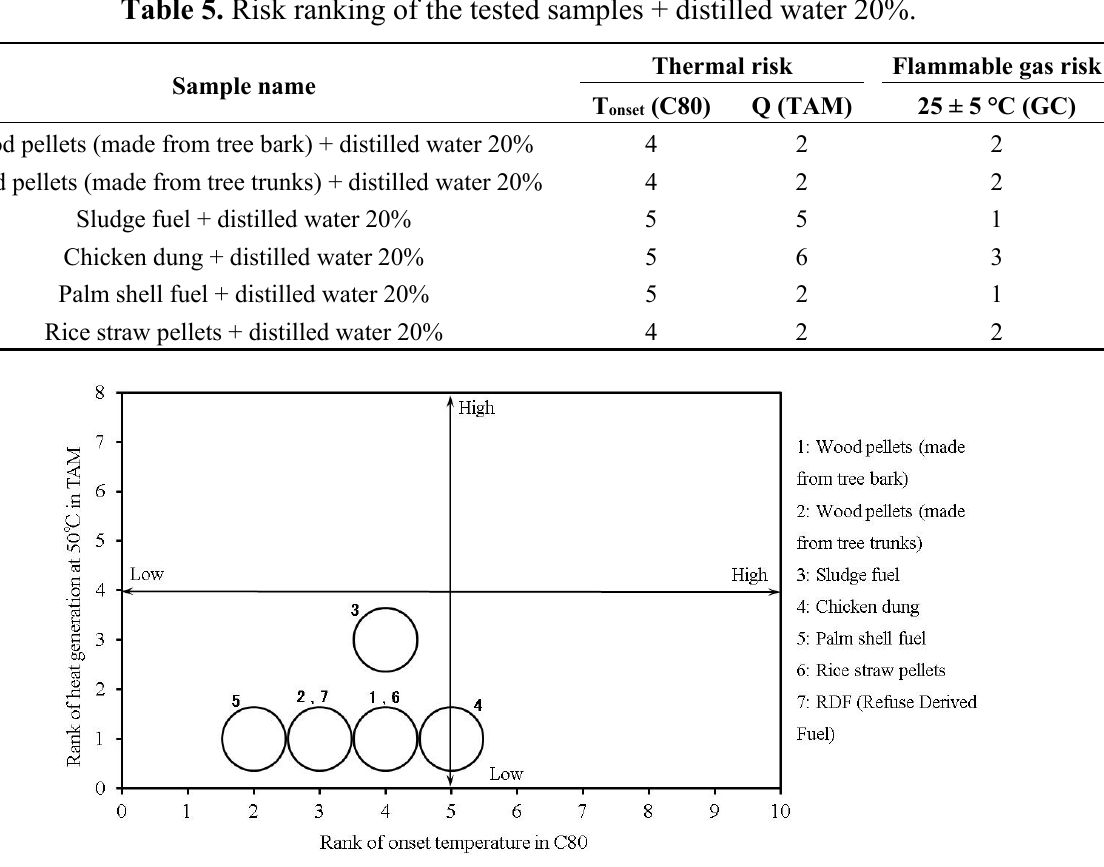
Figure 17. Comparison of risks for onset temperature, heat generation, and flammable gas generation for biomass